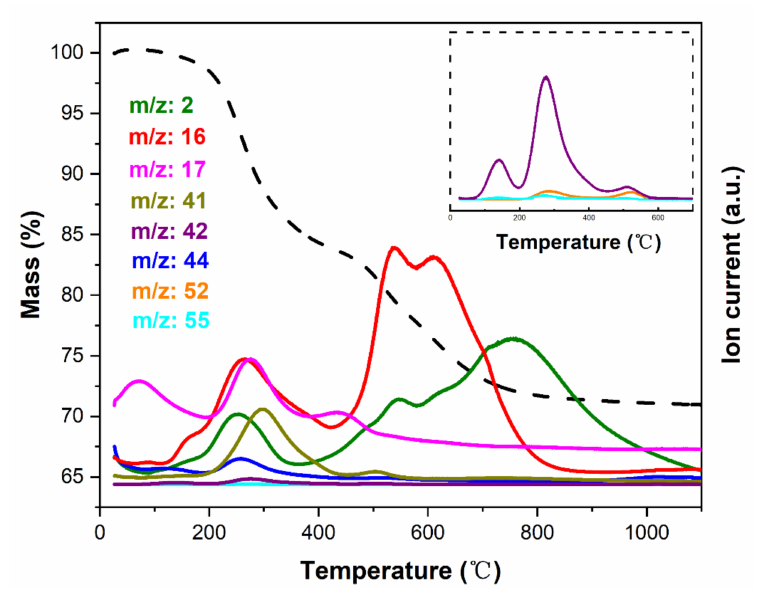
Figure 5. Results of simultaneous gravimetry (dashed lines)-mass spectrometry analysis of the synthesized Du1800-Pd precursor. The inset shows the mass spectra on an enlarged scale.